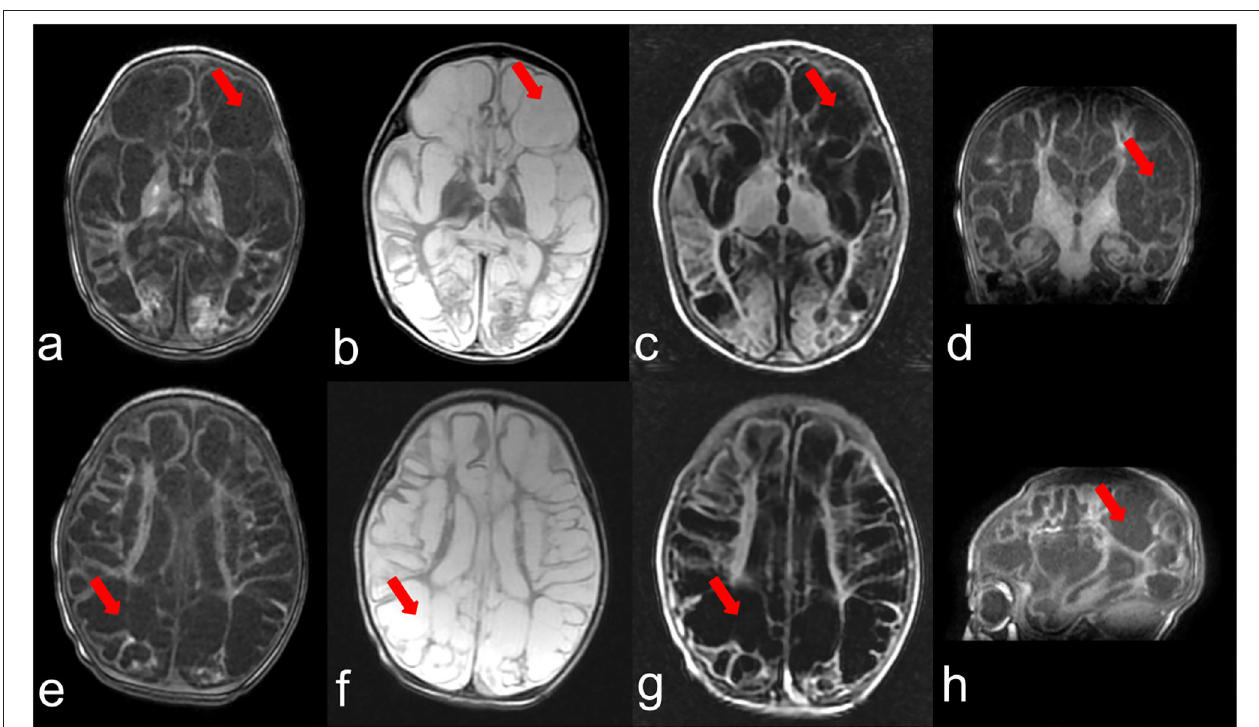
FIGURE 1 | Brain MRI at the age of 3 months. (a–c) represent T1,T2,T2-FLAIR weighted images of one section and (e–g) indicate T1,T2,T2-FLAIR weighted images of another section, respectively. (d,h) show T1 weighted images of the coronal plane and sagittal plane. The arrows point out the representing lesions in each